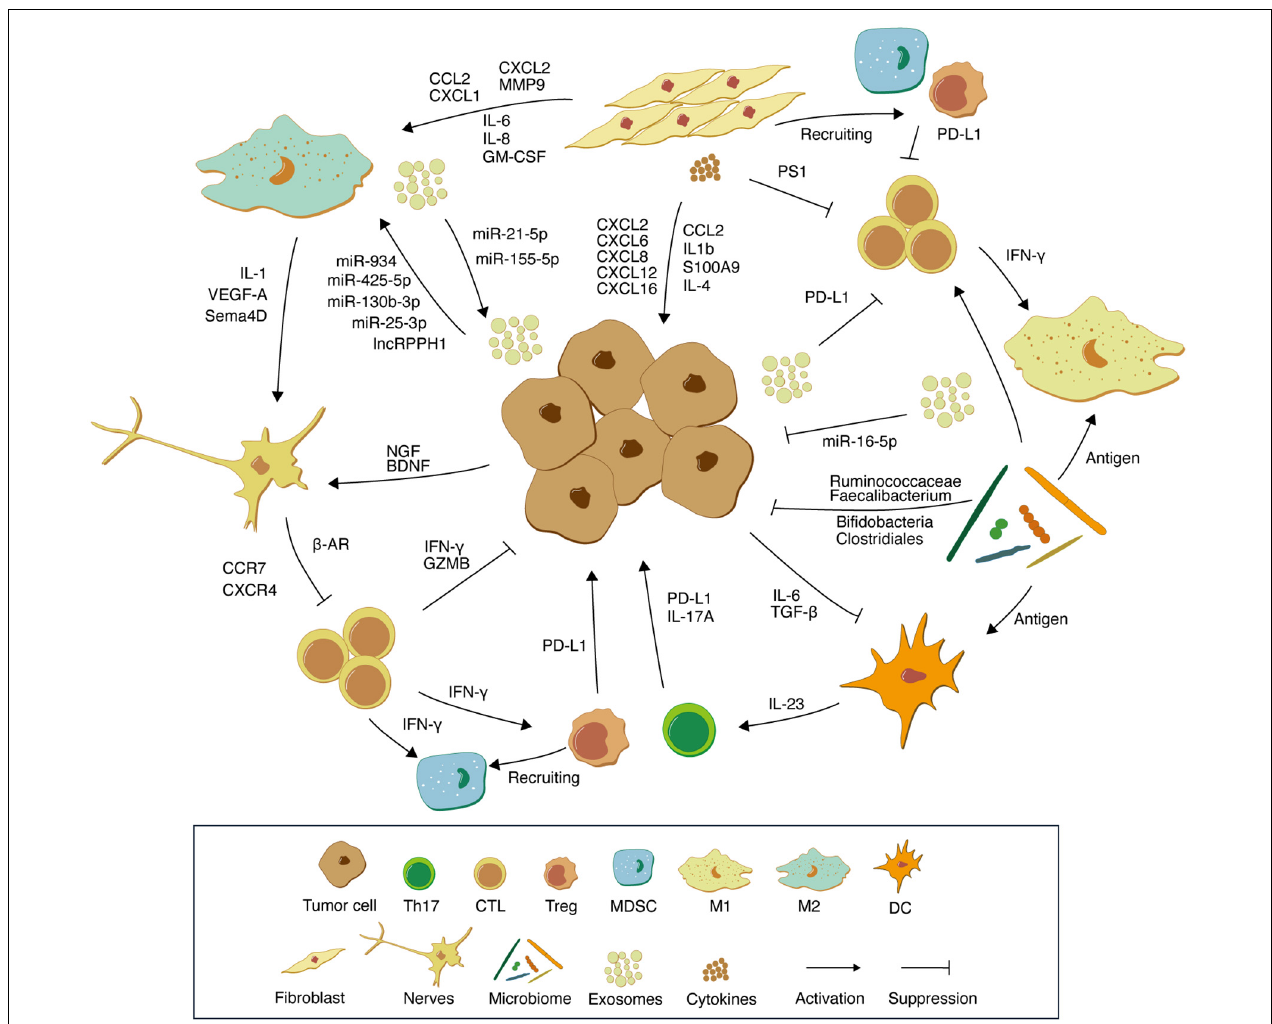
FIGURE 1 | Schematic representation of the interactions between tumor cells and various components of the TME. Tumor-derived exosomes carrying PD-L1 molecules and multiple microRNAs inhibit M1-type macrophage and T cell proliferation. M2-type macrophages and tumor cells promote mutual growth through exosomal microRNAs and jointly mediate tumor immune escape. CAFs recruit suppressor immune cells such as MDSCs and Tregs by secreting multiple chemokines. In addition, CAFs promote tumor cell proliferation by secreting cytokines such as IL-1 β , IL-4, and S100A9. NGF and BDNF in TME are able to increase neuronal cell abundance, which in turn leads to an increase in adrenergic signaling, resulting in the accumulation of norepinephrine and promoting tumor growth. The microbiome enhances anti-tumor immunity through antigen activation of DCs and M1-type macrophages. In addition, microflora beneficial for tumor immunotherapy such as Bifidobacteria , Clostridiales , Ruminococcaceae, and Faecalibacterium activate antitumor immunity through their metabolites. In TME, non-immune cell components create a “soil” suitable for tumor cell growth by communicating with immune cells and tumor cells. Th17, T helper cell 17; CTL, Cytotoxic T lymphocytes; Treg, Regulatory T cells; MDSC, Myeloid-derived suppressor cells; M1, M1-polarized macrophages; M2, M1-polarized macrophages; DC, Dendritic